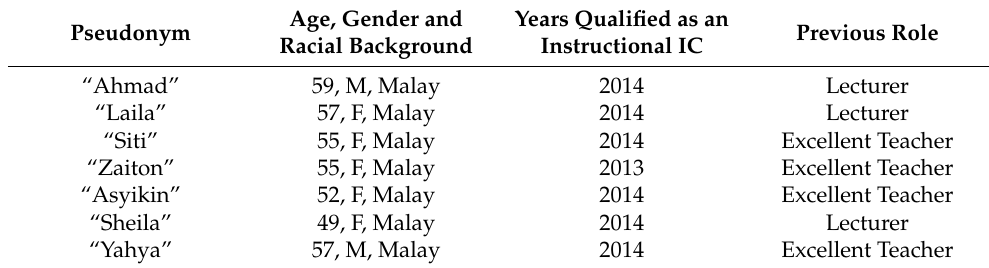
Table 1. Respondents’ characteristics and